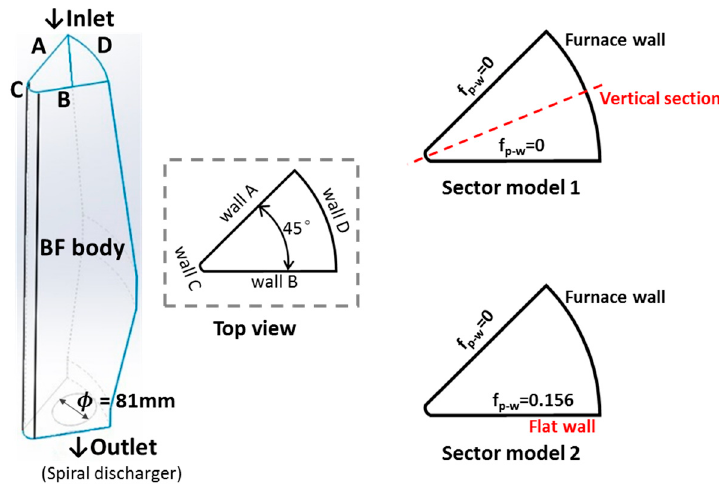
Figure 2. Direct element method (DEM) geometry of the two BF sector models.